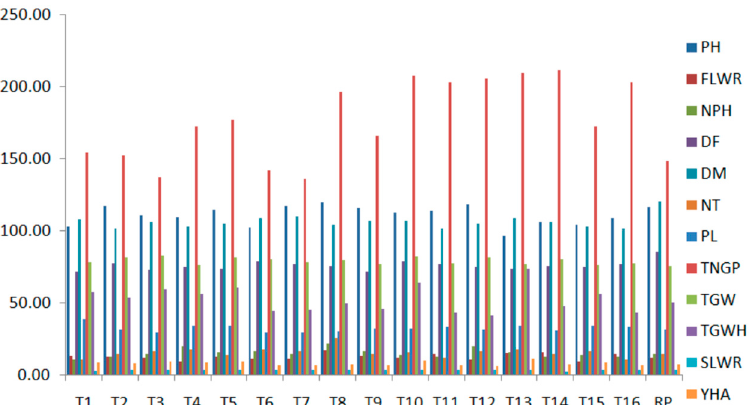
Figure 2. Quantitative traits performance of the newly improved selected lines and their recurrent parent (RP).